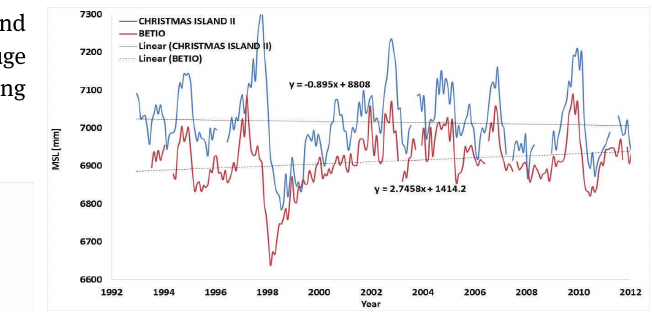
Fig. 5: Comparison of the Betio Island, Tarawa Atoll and the Christ- mas Island II tide gauge results over the same time window (data from [8]).